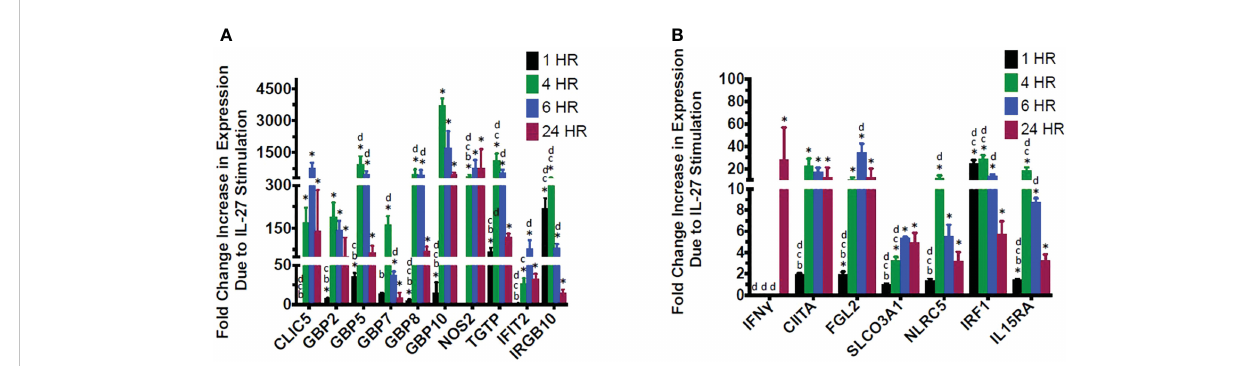
FIGURE 6 Validation of IL-27-induced transcripts in murine macrophages. Real time RT-qPCR validation of genes identi fi ed as upregulated by IL-27 by RNA sequencing of resident macrophages (A, B) . *p<0.05 by T-test of log-transformed delta cycle threshold values p<0.05 between gene expression timepoints by one-way ANOVA of log-transformed delta cycle threshold values. a=different versus expression at 1 hour. b=different versus expression at 4h. c=different versus expression at 6 h. d=different versus expression at 24h. Graphs depict mean + SD. Data representative of three independent